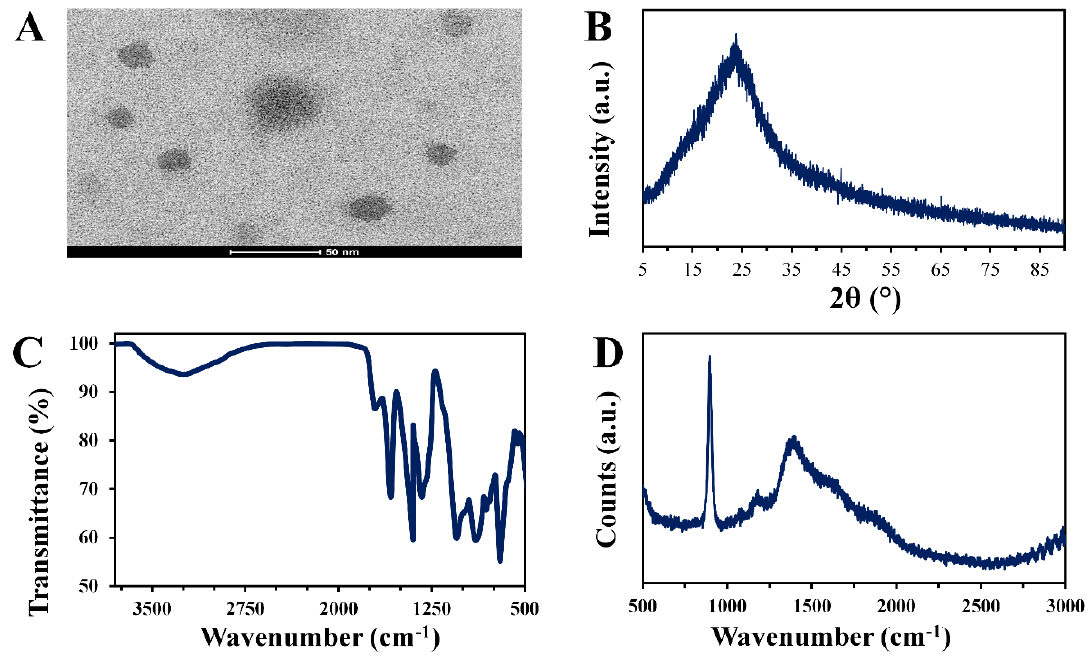
Figure 2. ( A ) TEM image, ( B ) XRD pattern, ( C ) FTIR spectra, and (D ) Raman spectra of the CNDs.